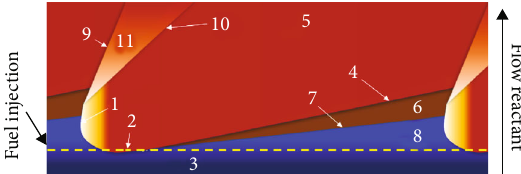
Figure 11: Schematic of a non-premixed air-breathing RDE fl ow fi eld under partial vitiation operation.